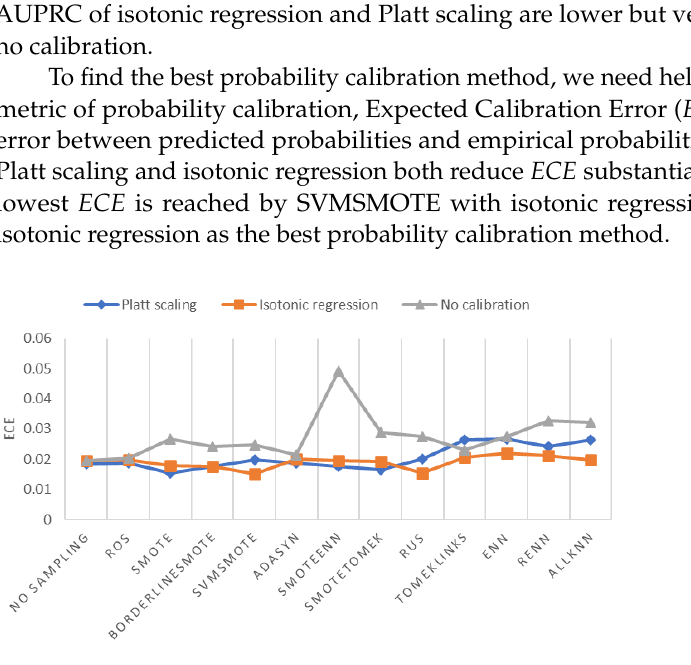
Figure 8. AUPRC of different sampling methods and probability calibration methods.